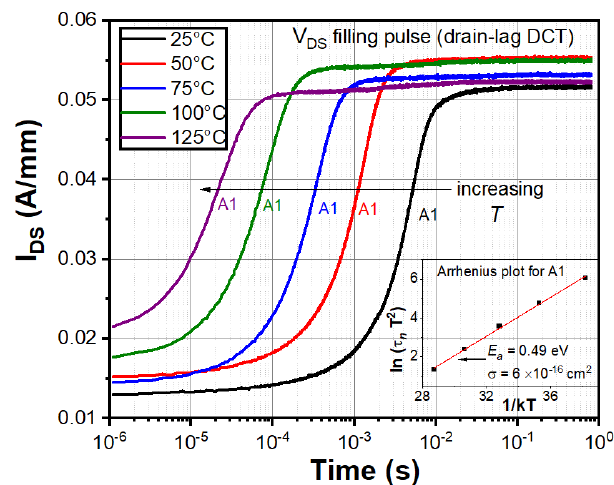
Figure 5. The drain current transient (DCT) spectroscopy of AlGaN/GaN HEMT acquired with the drain-lag filling pulse ( V DS pulsed from 10 to 20 V for 100 ms during the trap-filling phase) at increasing temperature levels. The Arrhenius plot for A1 is displayed in the inset.